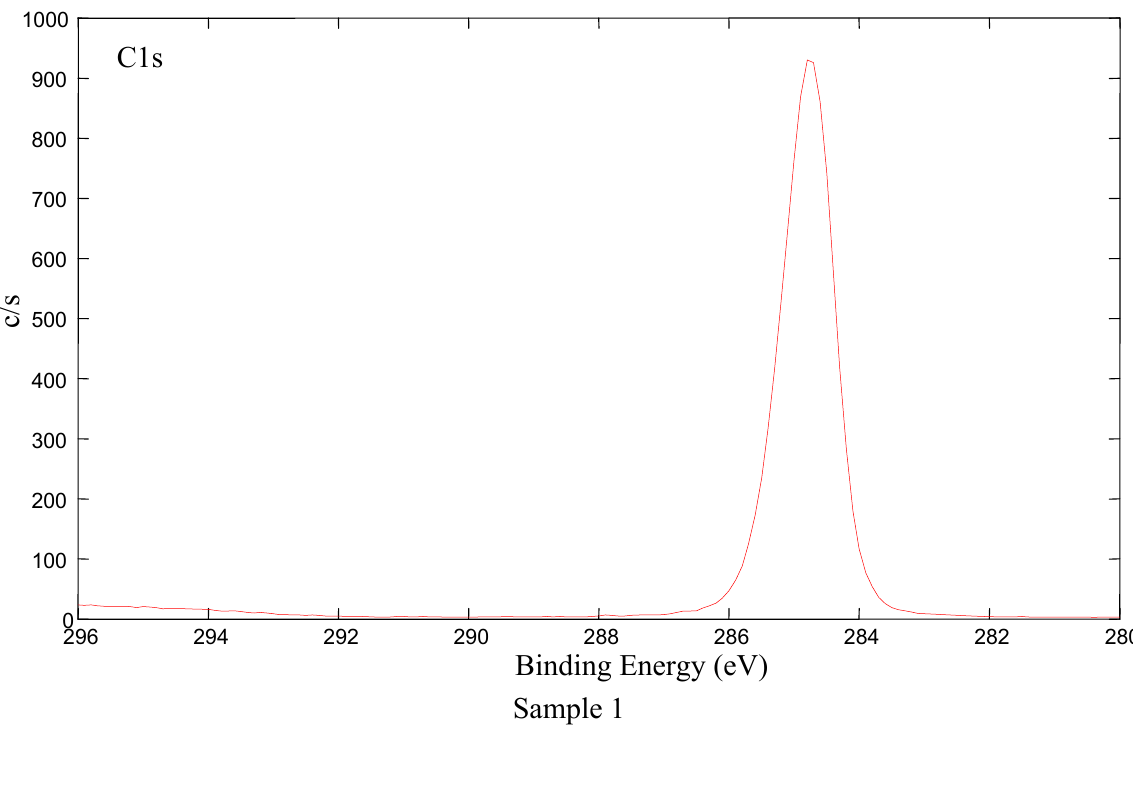
Figure 8. Carbon C1s peaks of Sample 1–5; Sample 1 - untreated LDPE; Sample 2 - plasma-treated; Sample 3 - AA grafted, Sample 4 - triclosan coated; Sample 5 - chlorhexidine coated.